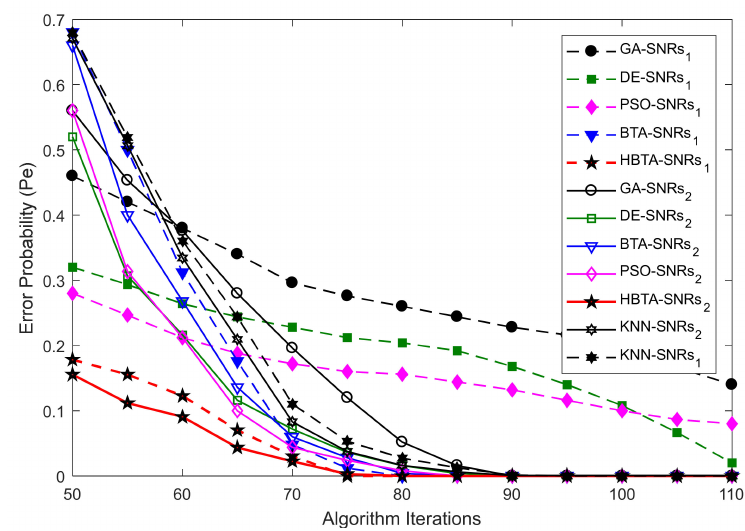
Figure 5. Error probability vs. iterations in the presence of AN-ANC users with SNRs 1 ( − 9.5 dB) and SNRs 2 ( − 0.5 dB).